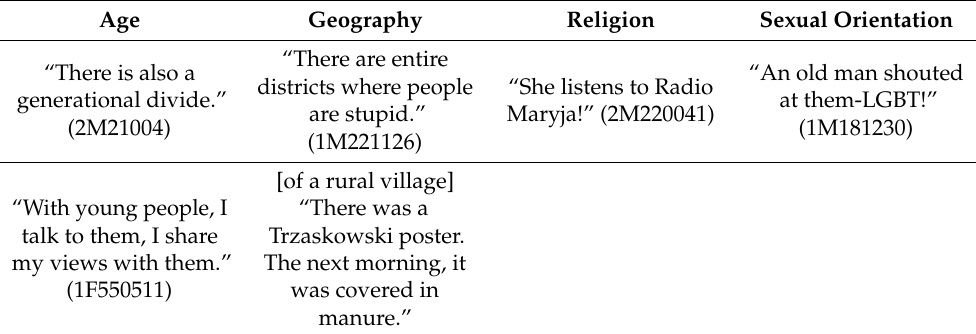
Table 2. Social, demographic, and cultural characterization of opposite